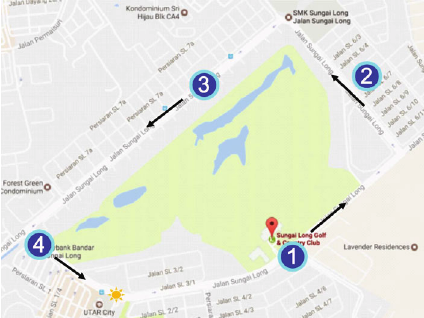
Figure 17: Driving path of the small truck at constant speed of 30 km/h for the study of the tracking accuracy of prototype mobile sun-tracking system under moving